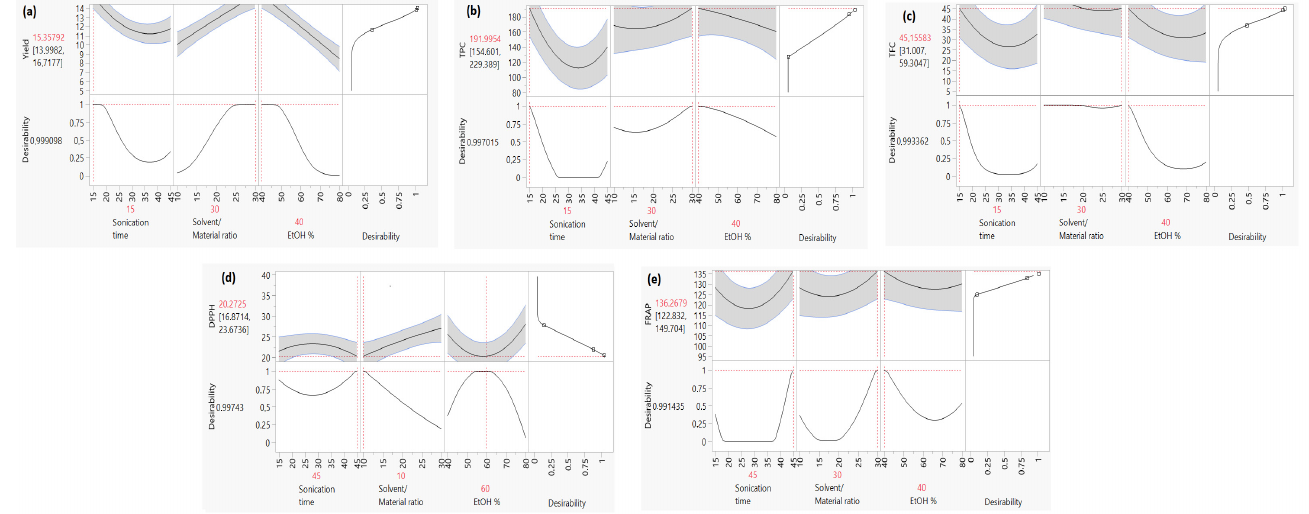
Figure 4. Desirability plots showing the precise parameters setting leading to the optimal value for